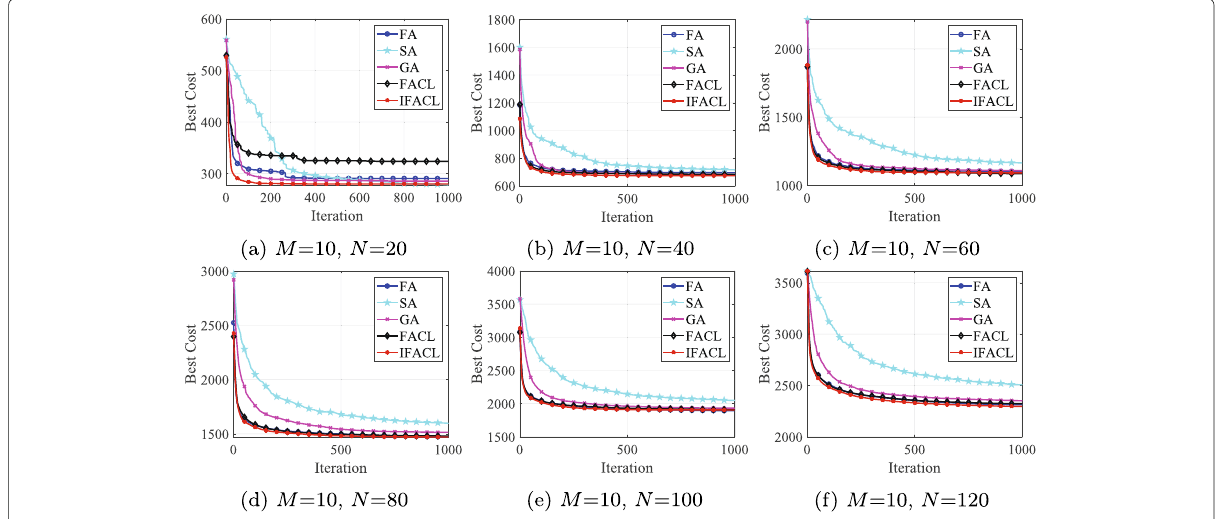
Fig. 9 Average convergence curve for each algorithm on SDominant instances of Dataset1 when the number of machines M